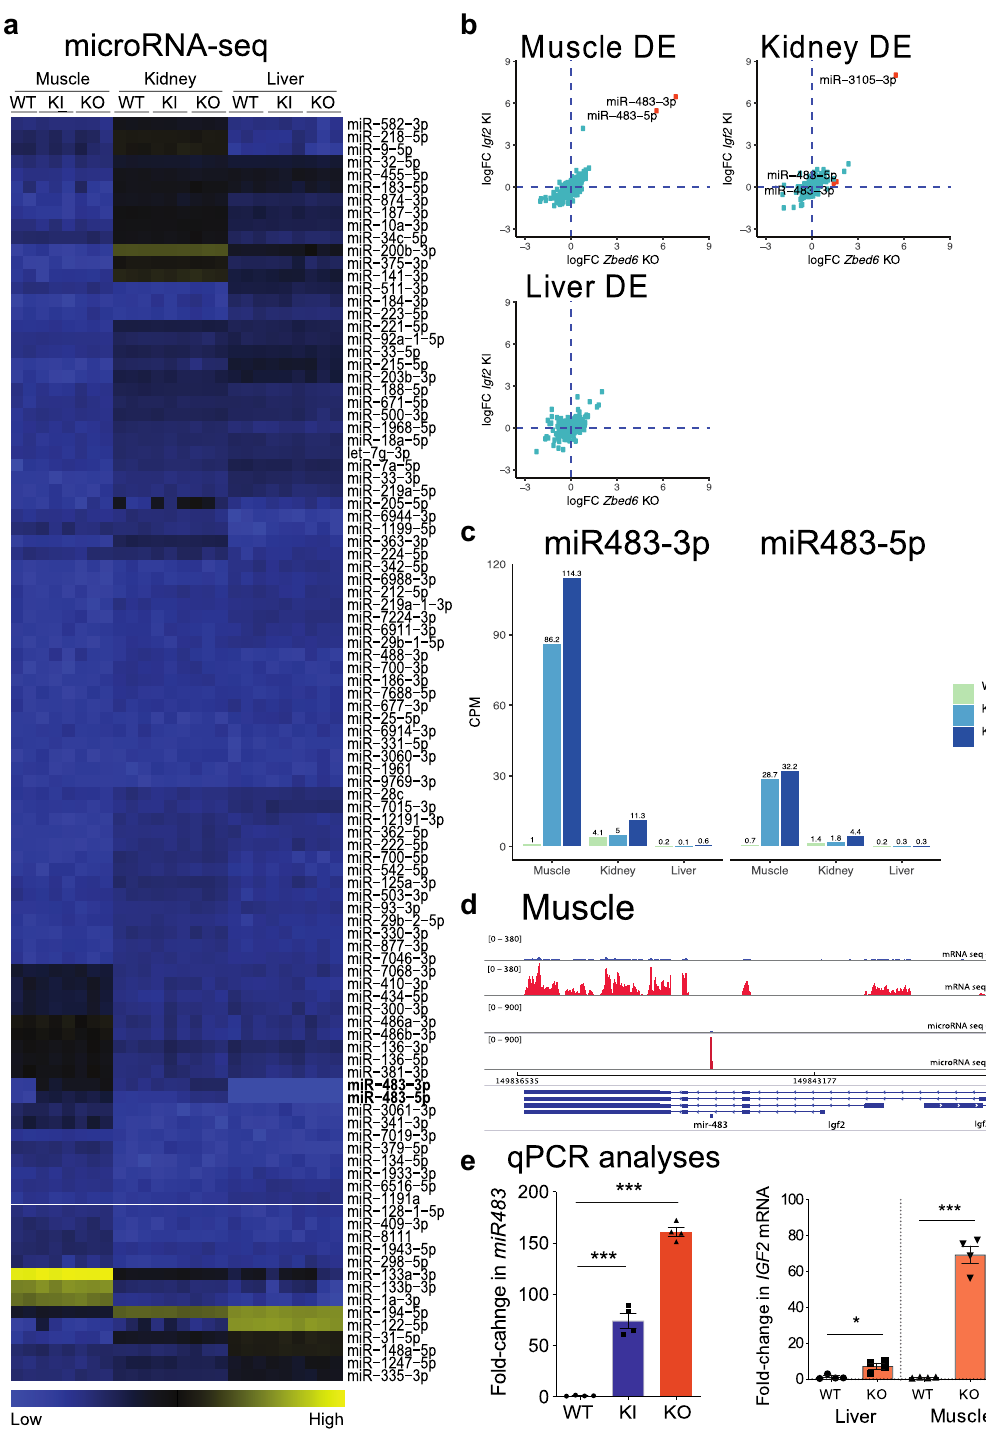
Figure 1. miRNA-seq analysis of mouse tissues in wild-type, Zbed6 -KO and Igf2 -KI mice. ( a ) Heatmap showing 100 expressed miRNAs across genotypes analyzed in each tissue separately, with miR483-3p and miR483-5p indicated in bold. ( b ) Scatterplots of log fold-change of miRNAs in Zbed6 -KO and Igf2 -KI mice compared with wild-type in muscle, kidney and liver tissues. ( c ) Expression of miR483-3p and miR483-5p in muscle, kidney and liver. The bars represent expression in counts per millions (CPM). ( d ) Uniquely mapped mRNA and miRNA reads at the Igf2 locus in wild-type and Zbed6 -KO muscle tissue. ( e ) qPCR analysis showing the expression levels of miR483 in muscle tissue of WT, Igf2 -KI and Zbed6 -KO mice (left) and of Igf2 mRNA in liver and muscle of Zbed6 -KO mice (right). Graph shows the fold changes (mean ± SEM) compared to WT. *** corresponds to P < 0.001 in a two-tailed Student’s